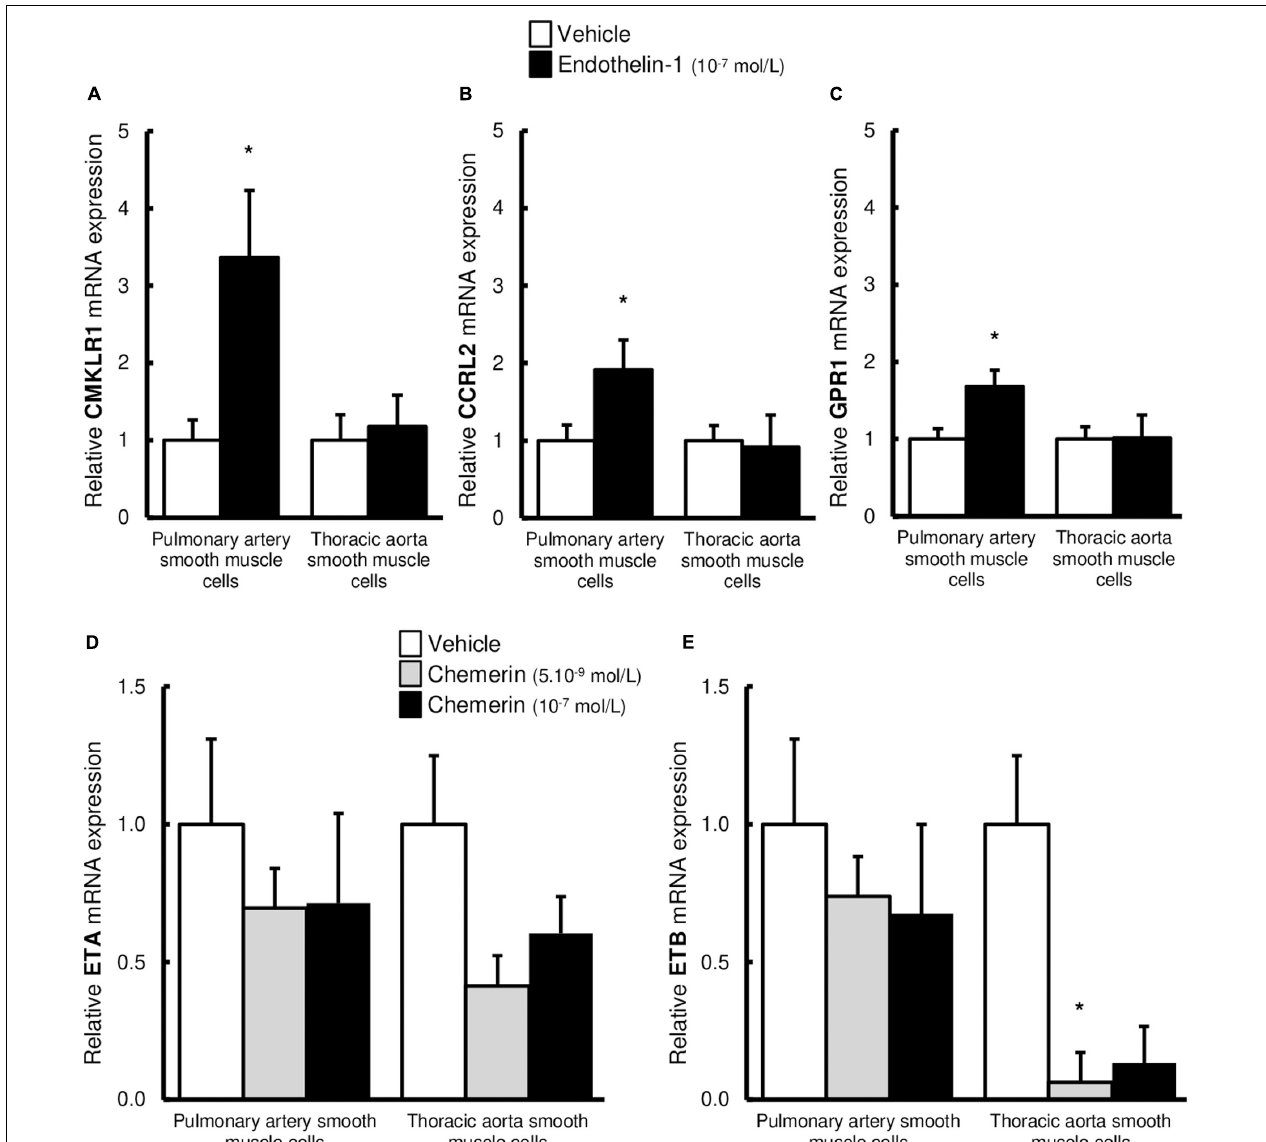
FIGURE 6 | Altered expression of chemerin receptors induced by endothelin-1 in pulmonary artery and thoracic aorta smooth muscle cells. Relative gene expression of chemerin receptors, the chemokine-like receptor 1 [ (A) , CMKLR1 also called ChemR23], the C-C chemokine receptor-like 2 [ (B) , CCRL2], and the G protein-coupled receptor 1 [ (C) , GPR1] in primary cultured pulmonary artery (five experiments in total) and thoracic aorta (seven experiments in total) smooth muscle cells isolated from Wistar rats ( n = 5). After 24-h serum starvation, smooth muscle cells were treated or not with recombinant rat endothelin-1 (10 − 7 mol/L) for 5 h. Quantification of relative gene expression was achieved by real-time quantitative polymerase chain reaction (RTq-PCR) using the Pfaffl method with normalization with the housekeeping genes, GAPDH and HPRT1. Results were expressed as relative fold increase over the mean value of relative mRNA expression of the vehicle (0% FCS)-treated group arbitrarily fixed to 1 and presented as mean ± SEM. *0.01 < p < 0.05 compared to corresponding vehicle-treated condition. Relative gene expression of endothelin receptors type A [ (D) , ETA] and B [ (E) , ETB] in primary cultured pulmonary artery (six experiments in total) and thoracic aorta (six experiments in total) smooth muscle cells isolated from Wistar rats ( n = 5). After 24-h serum starvation, smooth muscle cells were treated with recombinant mouse chemerin (5.10 − 9 and 10 − 7 mol/L) for 5 h. Quantification of relative gene expression was achieved by real-time quantitative polymerase chain reaction (RTq-PCR) using the Pfaffl method with normalization with the housekeeping genes, GAPDH and HPRT1. Results were expressed as relative fold increase over the mean value of relative mRNA expression of the vehicle (0% FCS)-treated group arbitrarily fixed to 1 and presented as mean ± SEM. * p < 0.05 compared to corresponding vehicle-treated